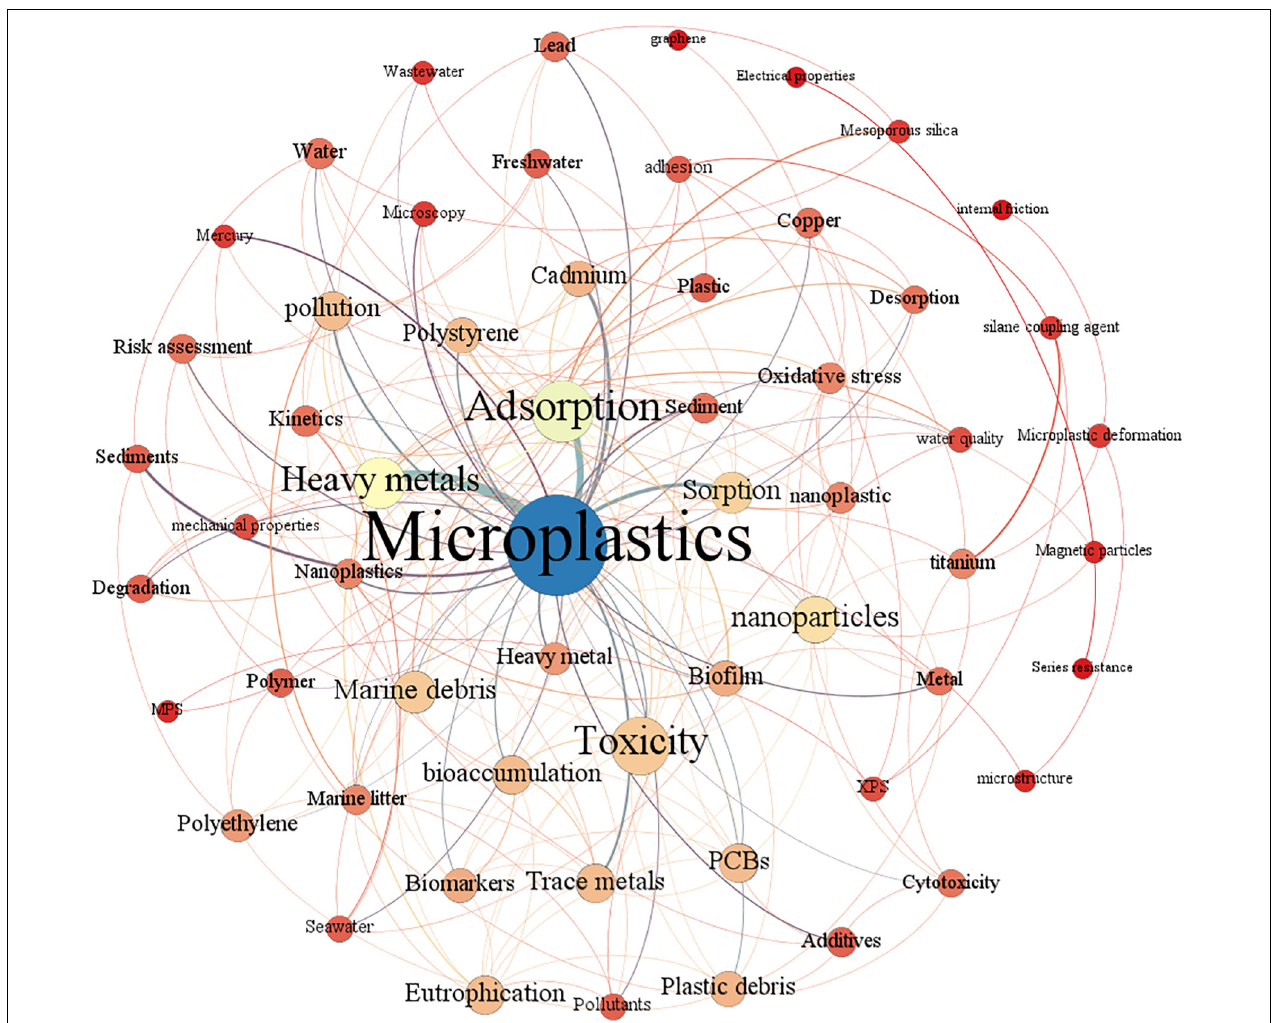
FIGURE 2 | Co-occurrence analysis of keywords with a word frequency of more than five times. The data come from a literature search with MPs and heavy metals as the subject terms. Each node is represented as a keyword, edges represent the link between keywords, the color of the node is rendered in degrees, and the color of the edge is rendered in the weight of the